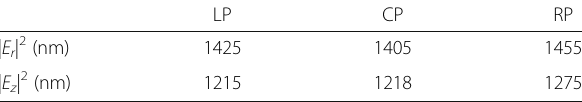
Table 1 The focal length in the transverse and